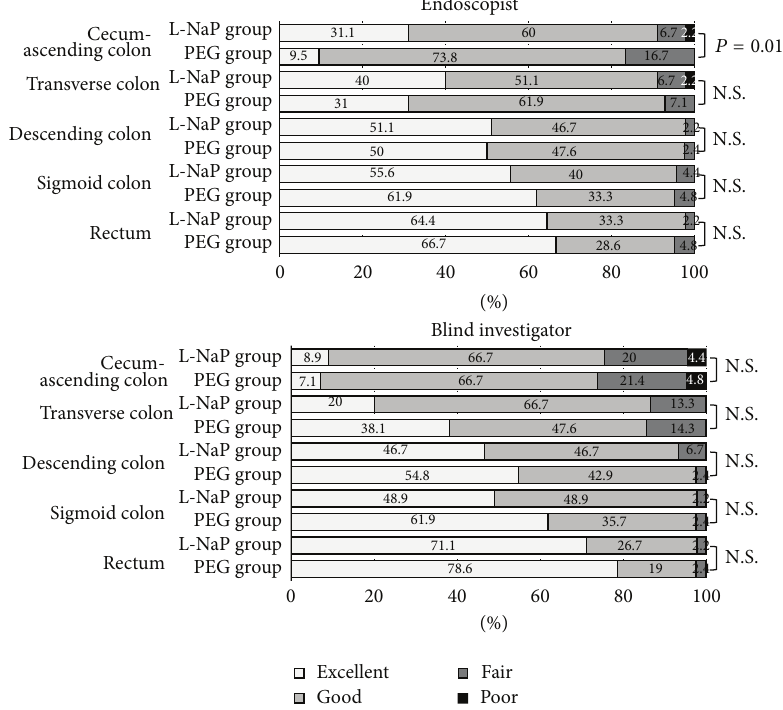
Figure 2: Efficiency of bowel cleansing in patients undergoing colonoscopy. Colon cleansing was evaluated by endoscopists and blinded investigators. As for the colon-cleansing effect in the cecum-ascending colon, L-NaP was rated to be superior to PEG. In other segments, there were no significant differences between the 2